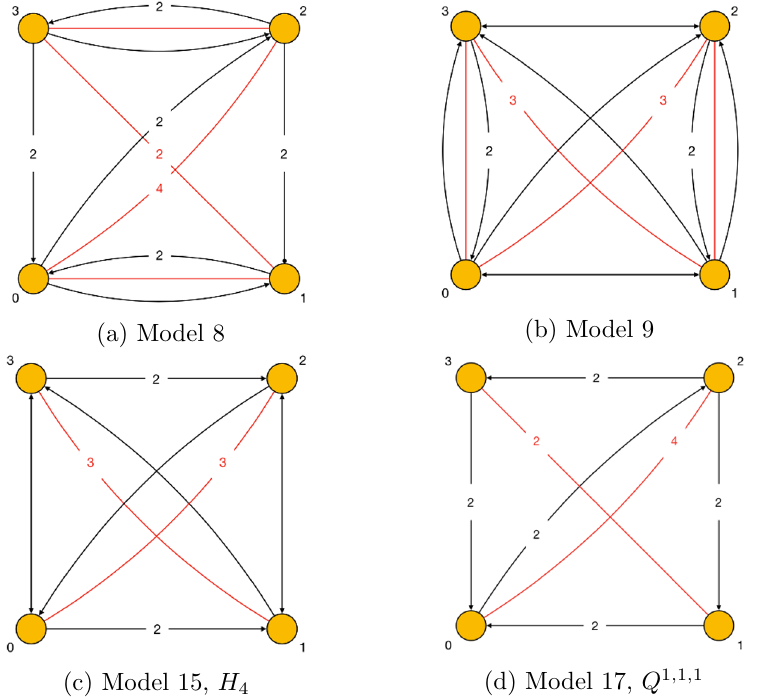
Figure 7. Quivers associated to S 2 and with a toric CY 4